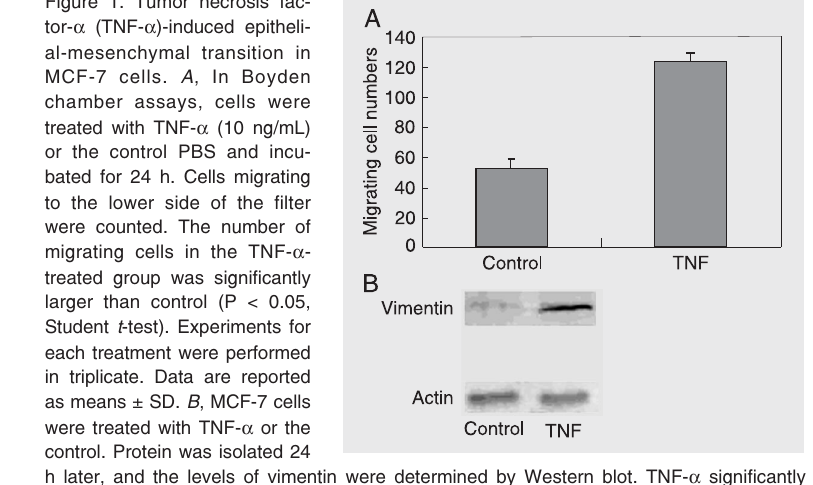
Figure 1. Tumor necrosis fac- tor- α (TNF- α )-induced